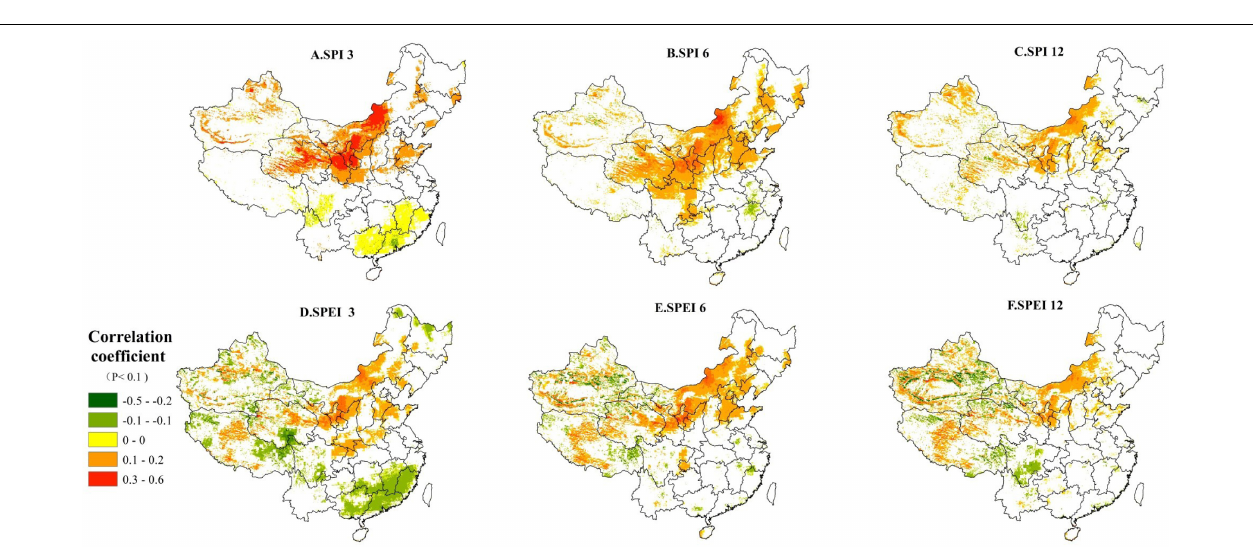
FIGURE 4 | The frequency of droughts in China from 1982 to 2012 (SPEI3). (A) Mild droughts (SPEI3 < 0), (B) moderate droughts (SPEI3 < –1), and (C) severe droughts (SPEI3 < –1.5).